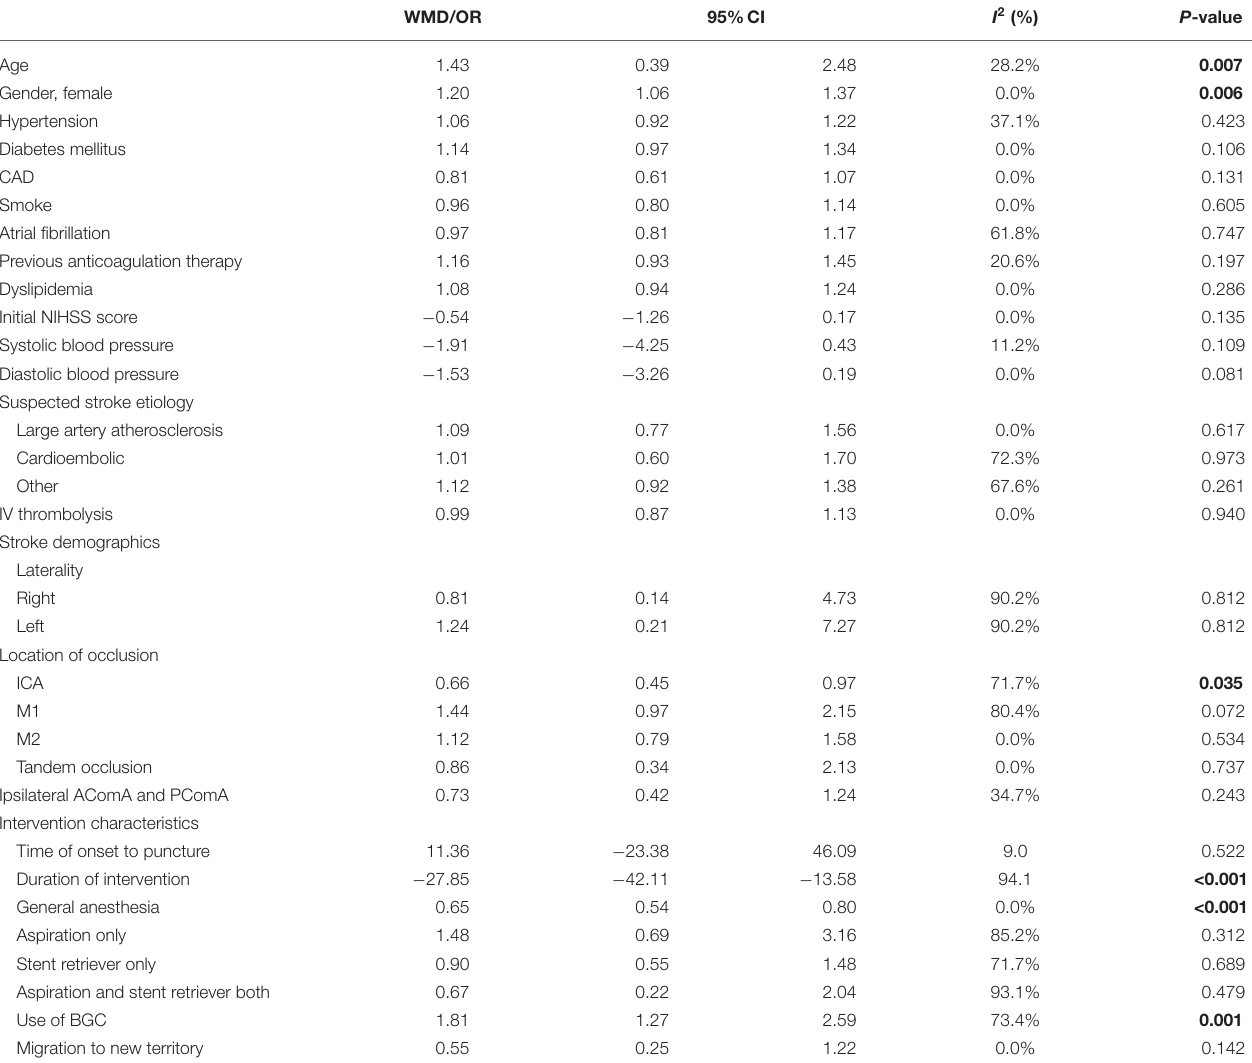
TABLE 3 | Summary of meta-analysis of influencing factors for achieving complete recanalization with FPE. WMD/OR 95%CI I 2 (%) P -value